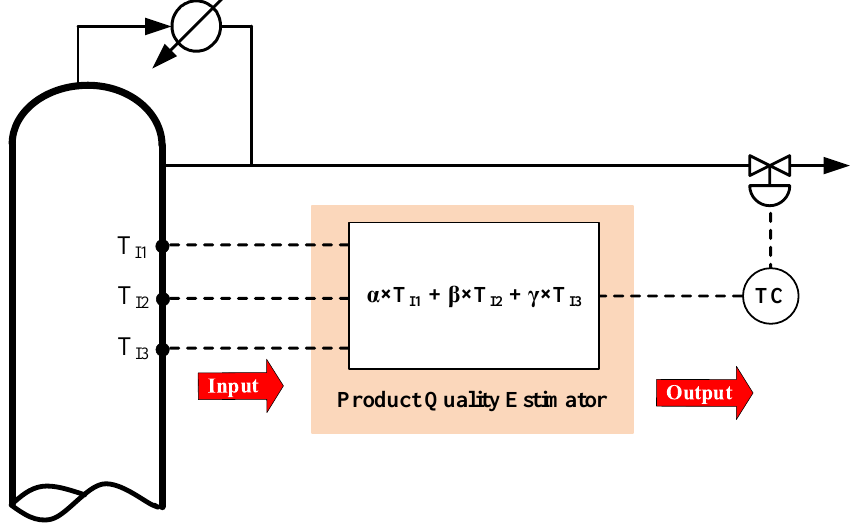
Figure 1. Schematic of the PQE proposed for controlling the DWDC.